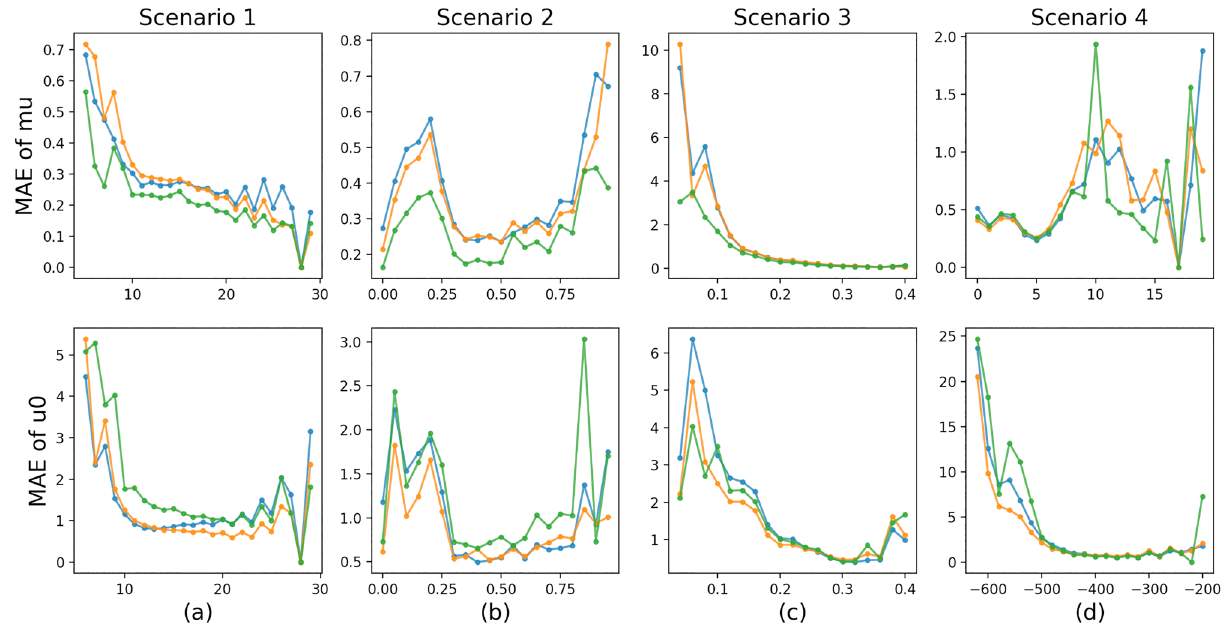
Figure 4. MAE comparison results of mu and u0 depending on indicators of the four biased sampling scenarios. The x -axises correspond to (a) number of atoms, (b) proportion of double/triple/aromatic bonds, (c) value of HOMO-LUMO gap (gap), and (d) value of the target (i.e., mu for the top and u0 for the bottom), respectively. The blue, orange and green lines correspond to the Baseline, IPS, and CFR approaches,